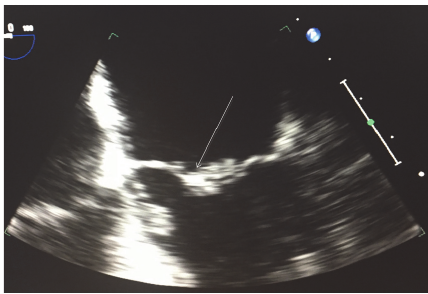
Figure 2: TEE showing possible small mitral valve